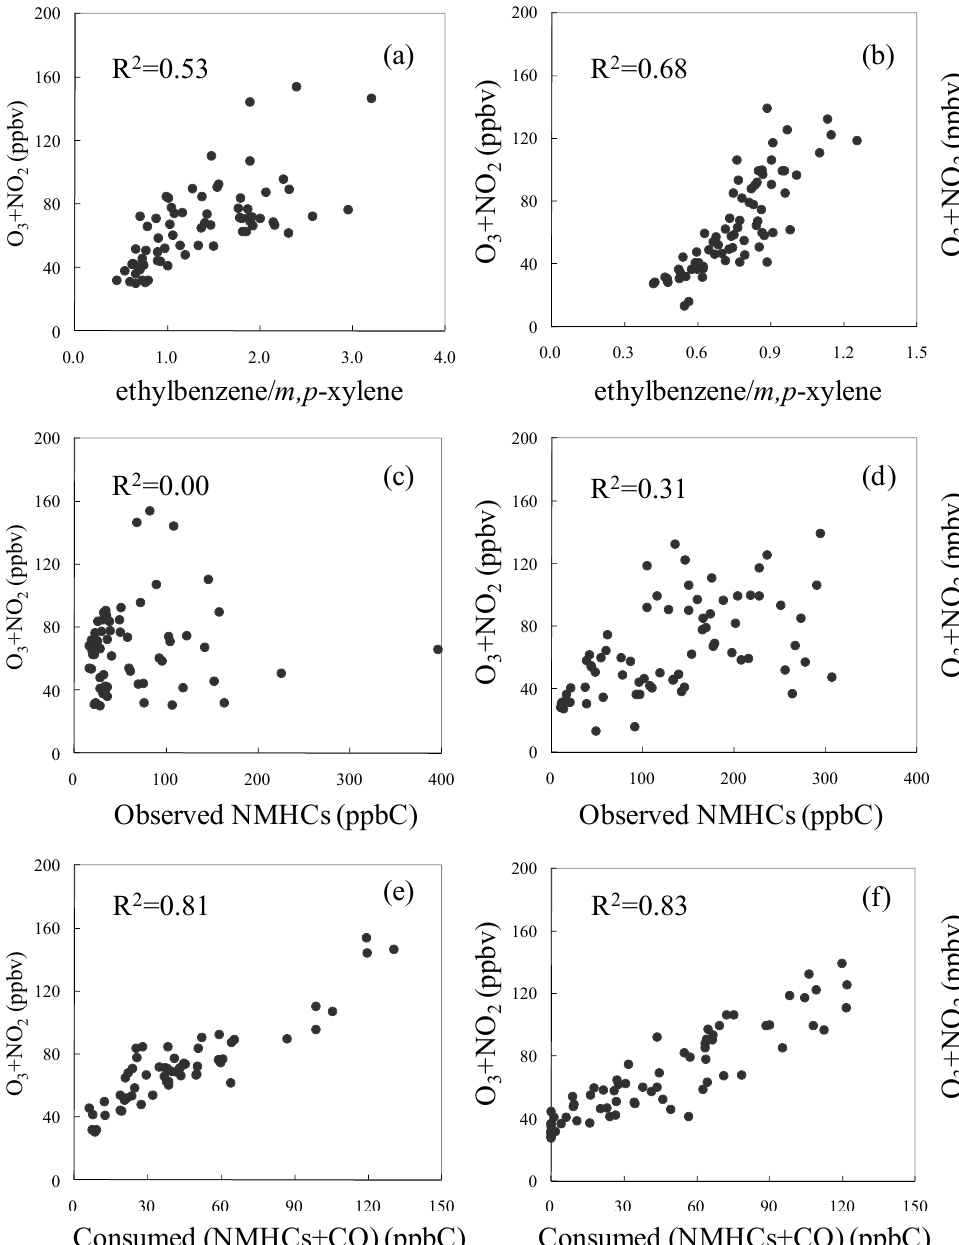
Figure 2. Scatter plots of oxidant (O 3 + NO 2 ) versus ethylbenzene/ m,p -xylenes ratio, observed total NMHC concentrations, and total consumed NMHCs + CO at BG, PRD ( a , c , e ) and PKU, Beijing ( b , d , f ). Data were selected from 13:00 to 15:00 at BG and 12:00 to 14:00 at PKU. (ppbC: parts per billion carbon, ppbv: parts per billion by volume).